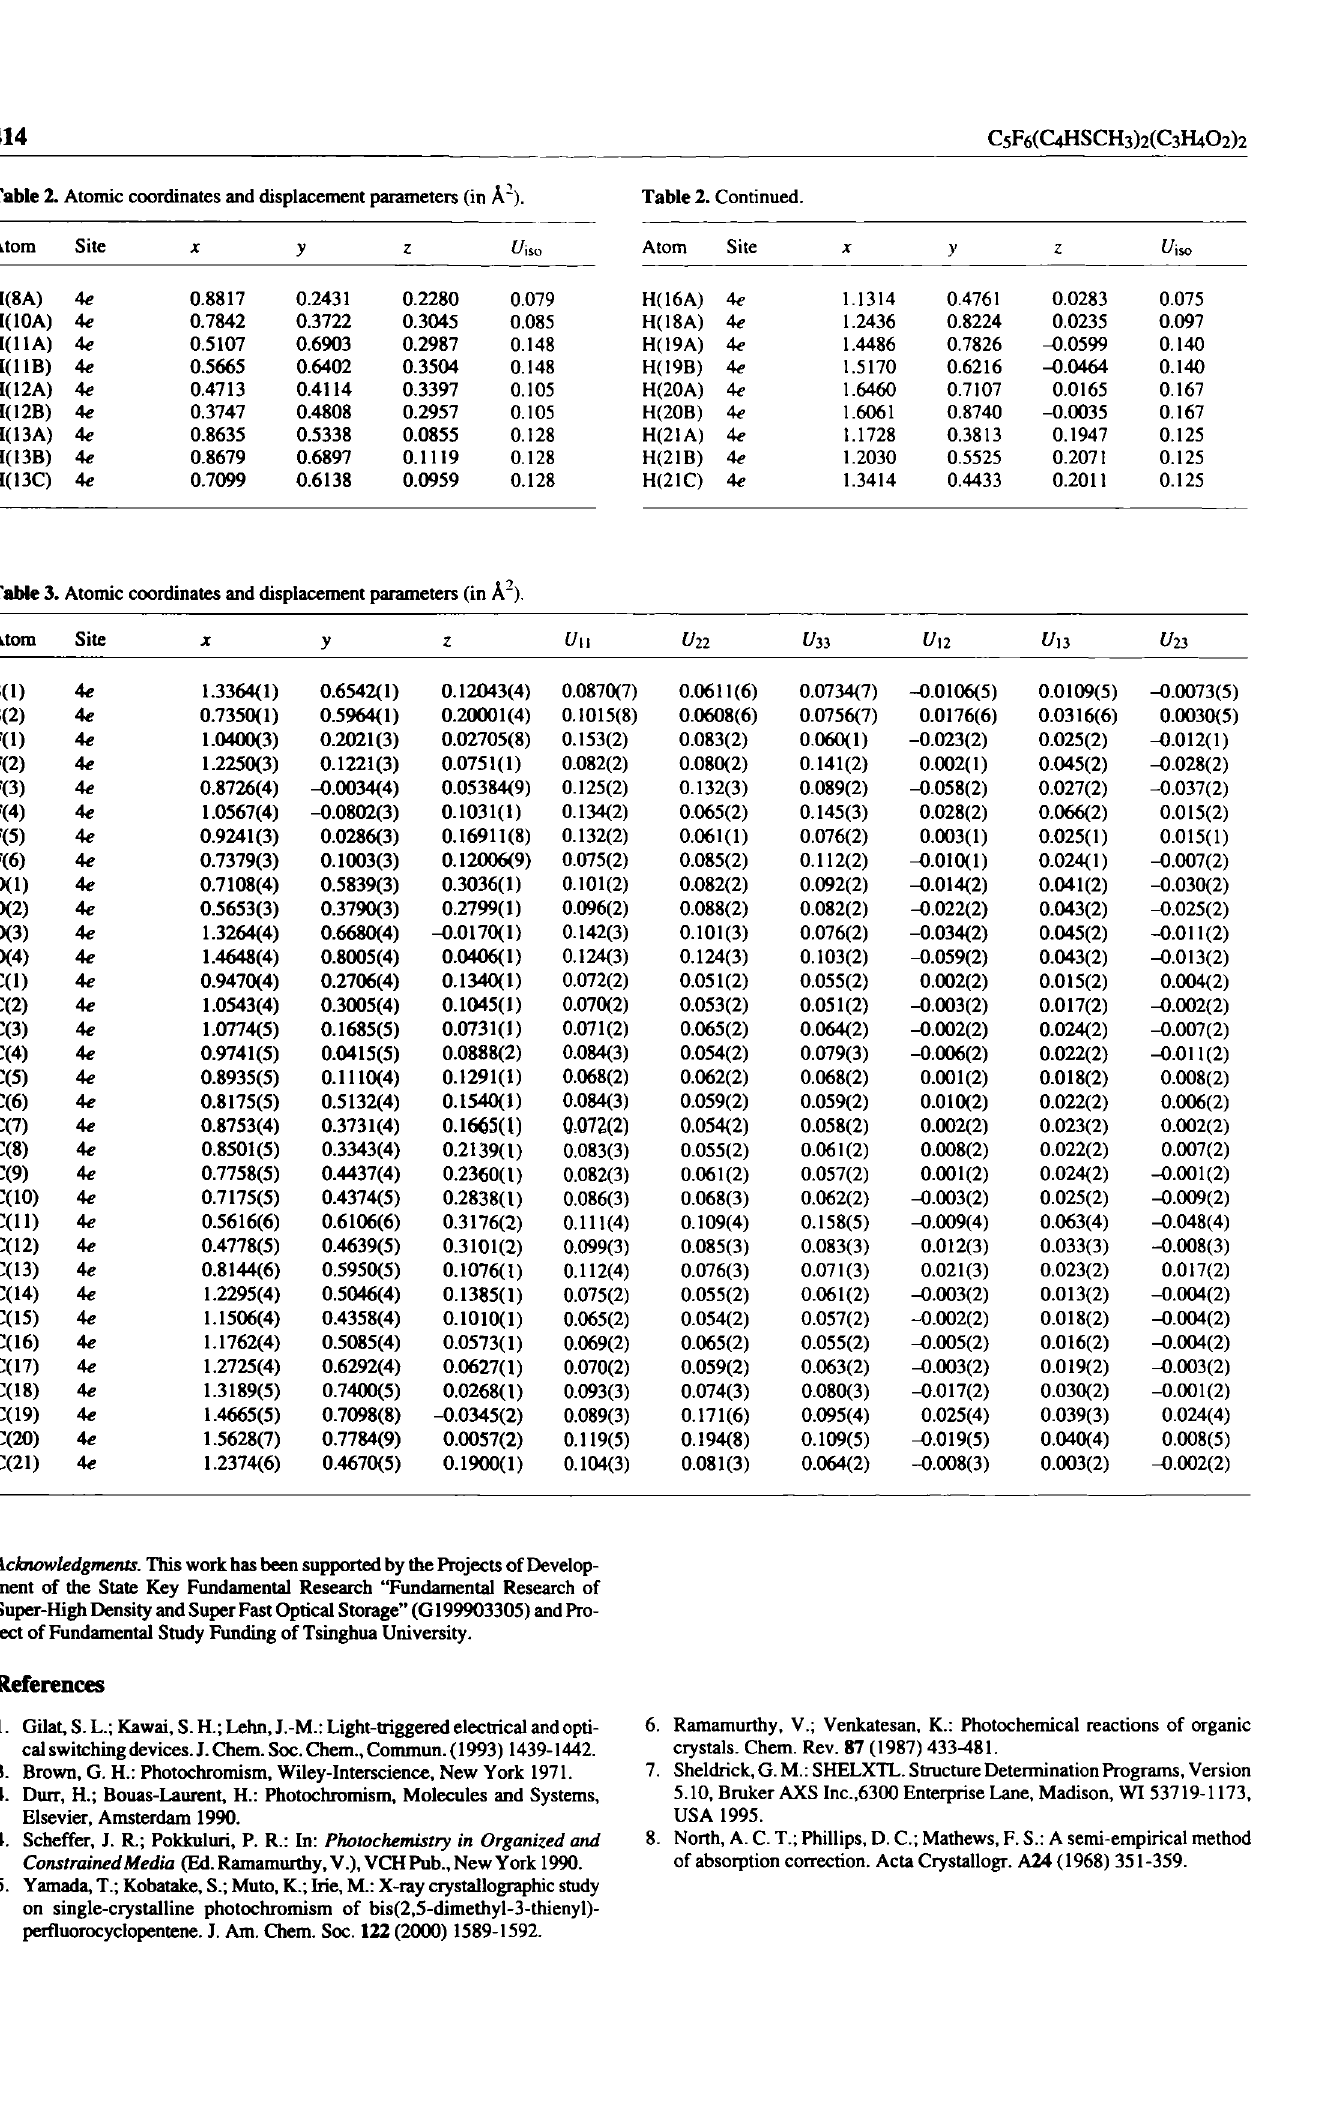
Table 3. Atomic coordinates and displacement parameters (in Â 2